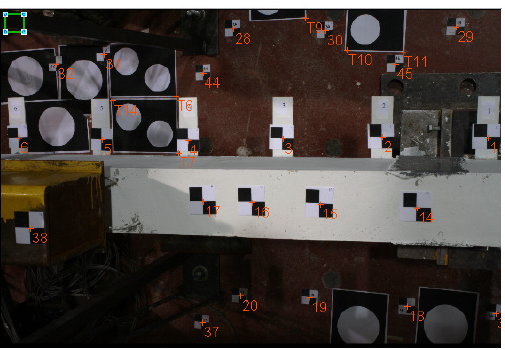
Figure 5. Example of the distribution of signalized targets on the floor, on the concrete beam, and on the Figure 3. Part of the metal frame built to hoist the cameras and the projectors of the digital photogrammetric system